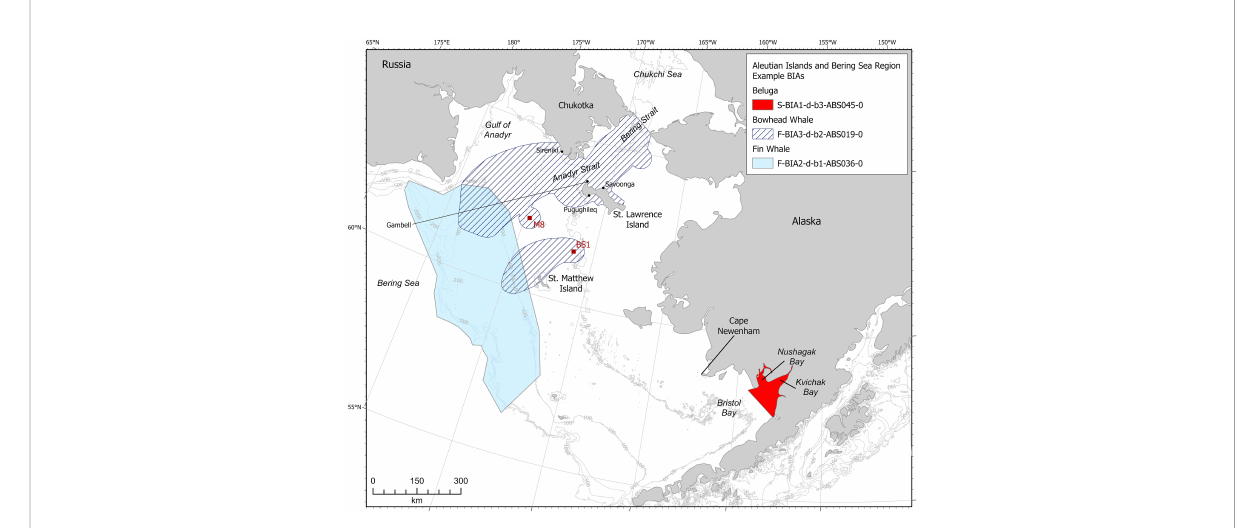
FIGURE 11 Aleutian Islands and Bering Sea region BIAs for bowhead whale, beluga, and fi n whale that were detailed in case